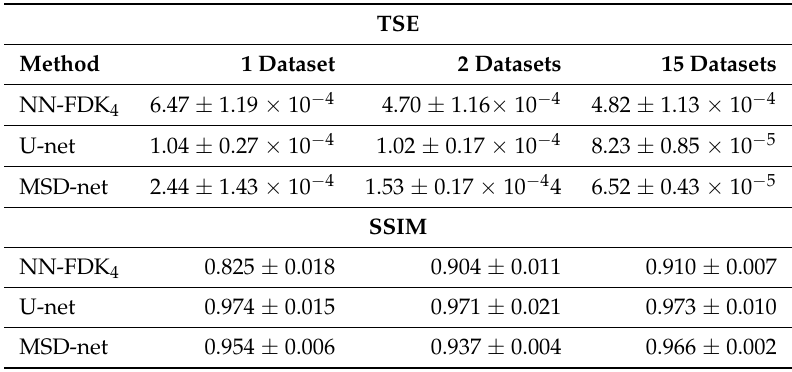
Table A1. Average and standard deviation of the quantitative measures computed over 20 different Defrise phantoms for various training scenarios. The reconstruction problems have a cone angle of 29.2 degrees and N a = 360 projection angles.